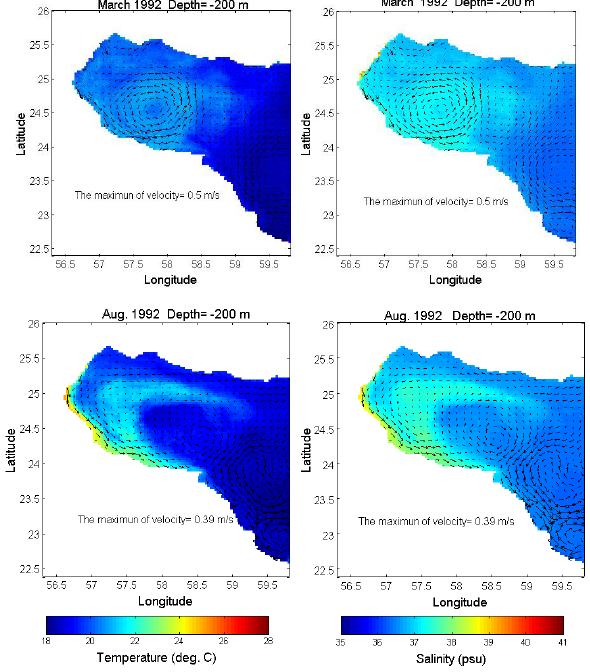
Fig. 16. Horizontal mean fields of temperature and salinity at depth 200m for March and